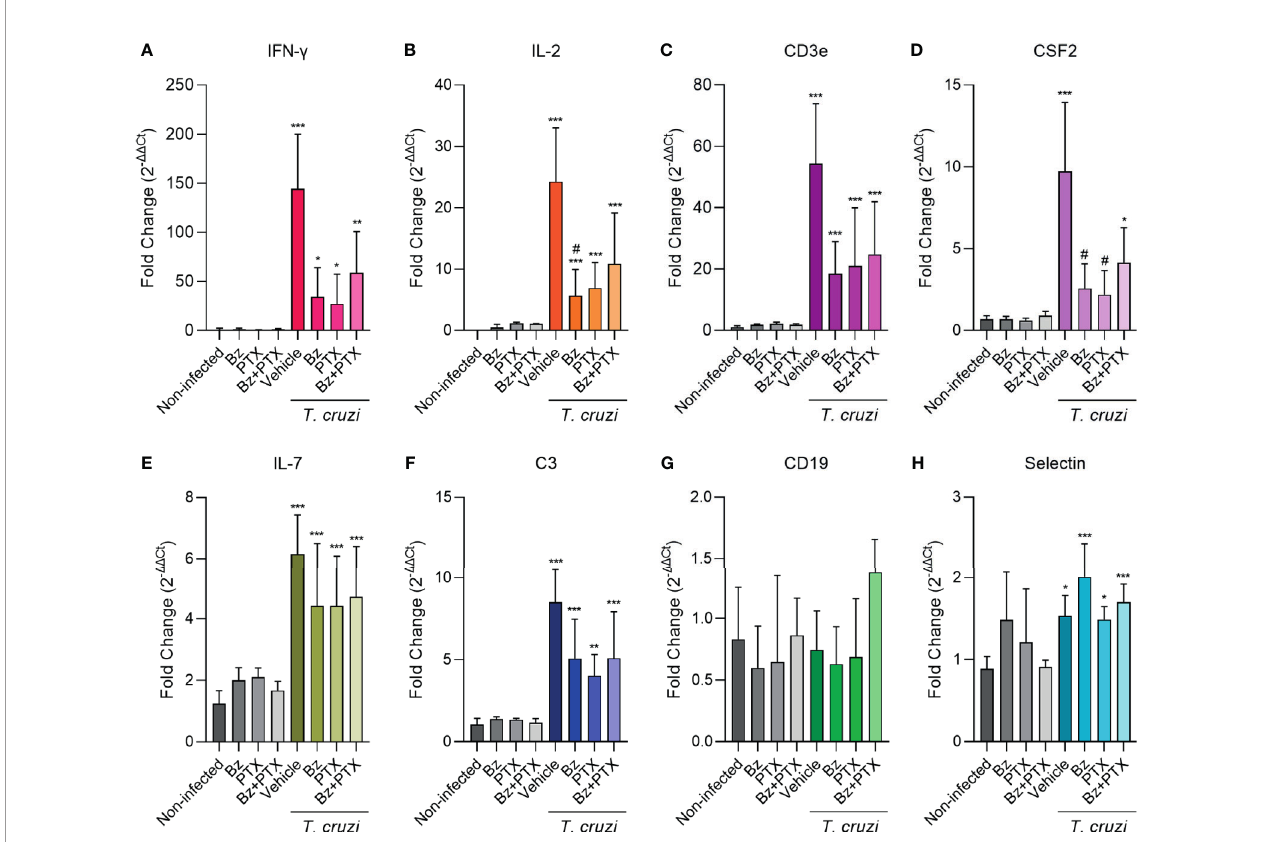
FIGURE 6 | Validation of selected immune response genes on individual samples. (A) IFN- g (vs. non-infected: vehicle: p < 0.001; Bz: p < 0.001; PTX: p < 0.001; Bz+PTX: p < 0.001), (B) IL-2 ( vs . non-infected: vehicle: p < 0.001; Bz: p = 0.013; PTX: p = 0.047; Bz+PTX: p = 0.005; vs . vehicle: Bz: p = 0.030), (C) CD3 e ( vs . non-infected: vehicle: p < 0.001; Bz: p < 0.001; PTX: p < 0.001; Bz+PTX: p < 0.001), (D) CSF2 ( vs . non-infected: vehicle: p < 0.001; Bz+PTX: p = 0.028; vs . vehicle: Bz: p = 0.027; PTX: p = 0.042), (E) IL-7 ( vs . non-infected: vehicle: p < 0.001; Bz: p < 0.001; PTX: p < 0.001; Bz+PTX: p = 0.001), (F) C3 ( vs . non-infected: vehicle: p < 0.001; Bz: p < 0.001; PTX: p = 0.007; Bz+PTX: p < 0.001), (G) CD19 ( vs . non-infected: ns; vs . vehicle: ns), and (H) selectin ( vs . non-infected: vehicle: p = 0.013; Bz: p < 0.001; PTX: p = 0.034; Bz+PTX: p = 0.001) were assessed by real-time RT-qPCR in each group of the experiment. Number of mice per group: non-infected = 3/group; vehicle = 4; Bz = 5; PTX = 3; Bz+PTX = 5. The expression is shown as mean ± SD for each group by 2 - DD Ct relative quanti fi cation method. For all graphs, signi fi cance was determined using one-way ANOVA all pairwise multiple comparison vs . non-infected (*p < 0.05, **p < 0.01, ***p < 0.001; ns, non- signi fi cant) and vs . vehicle (#p < 0.05; ns, non-signi fi